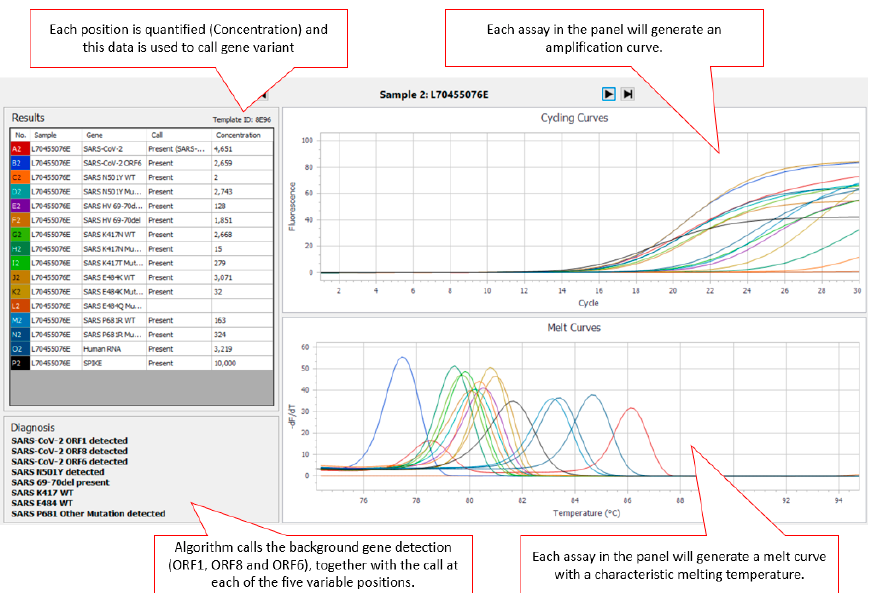
Figure 1. Screenshot of assay output using AusDiagnostics results software. The upper right panel shows the amplification curves for the individual assays, while the lower right panel shows their respective amplicon melt curve. The left panels show sample information and the output of the diagnostic algorithm.